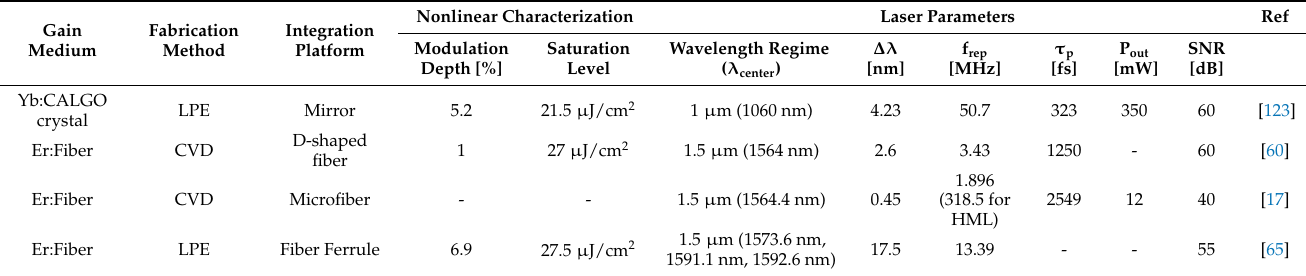
Table 3. Nonlinear optical characteristics and applications in laser cavities using ReS 2 for mode-locked lasers. Gain